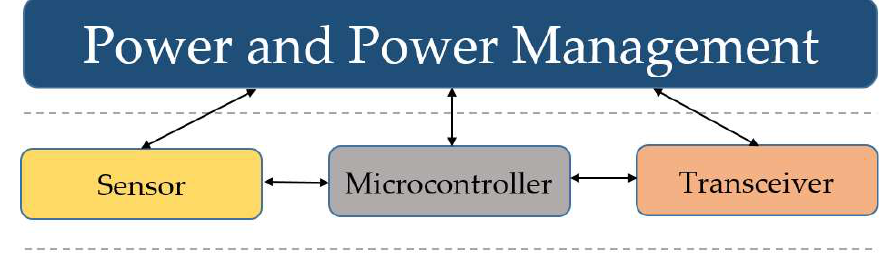
Figure 11. WSN Sensor Node Hardware Structure. Adapted from [75].